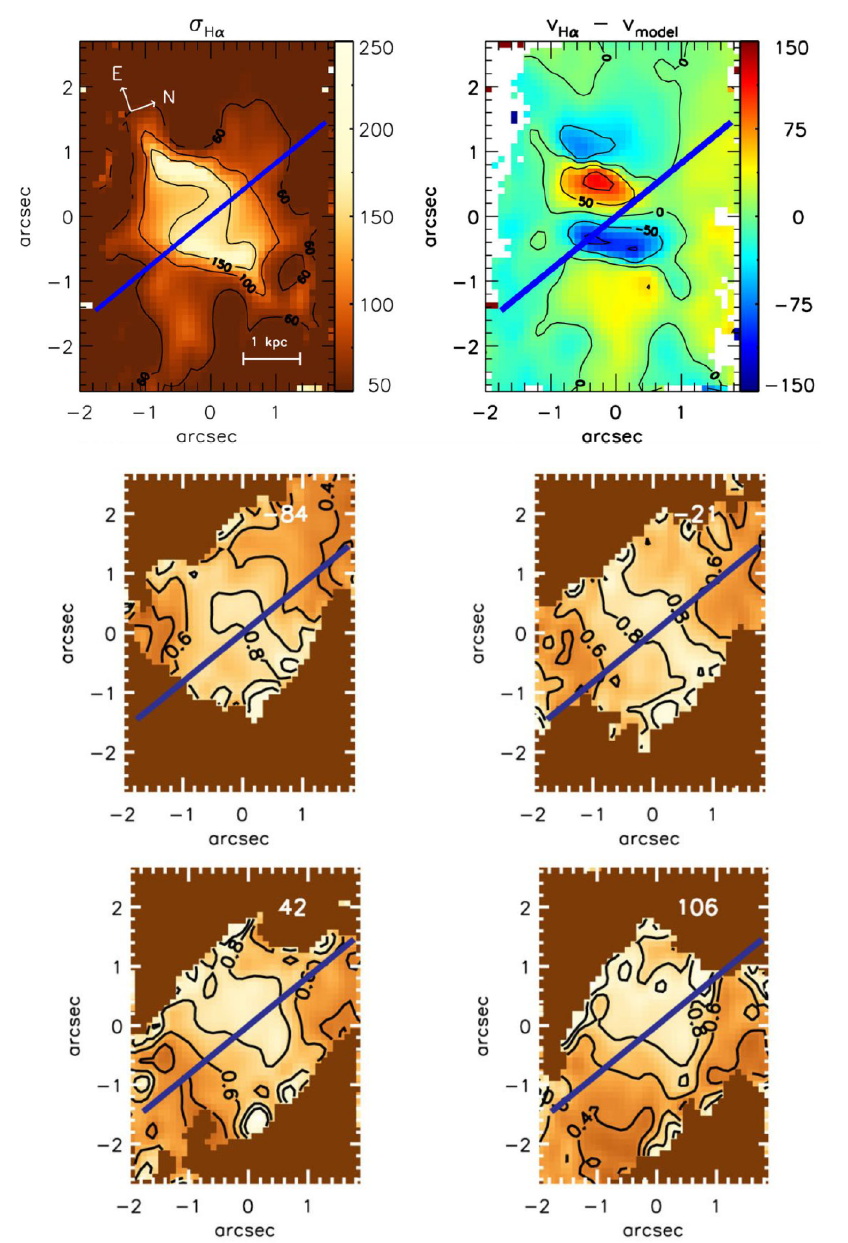
Figure 5. Gemini-GMOS IFS observations of the radio galaxy 3C33. H α velocity dispersion (top left), velocity residuals (top right, observed velocity field minus disk-like rotation model) and [N II ]/H α line ratio channel maps (middle and bottom panels), adapted from Couto et al. [92]. Channel map velocities ( − 84, − 21, 42 and 106 kms − 1 , clockwise from top left) are displayed in the top right corner of the panels. The blue line displays the large-scale radio jet orientation. An increase in the velocity dispersion is observed in the same region where velocity residuals are highest. The same velocities are spatially correlated with an increase of the [N II ]/H α line ratio (delineated by contours), indicating that shock-driven outflows are present in these regions, probably due to the jet-gas interaction. The calculations above are not restricted to radio-loud AGN, but are general to any type of outflow. For the ionized gas, the gas density is usually estimated using